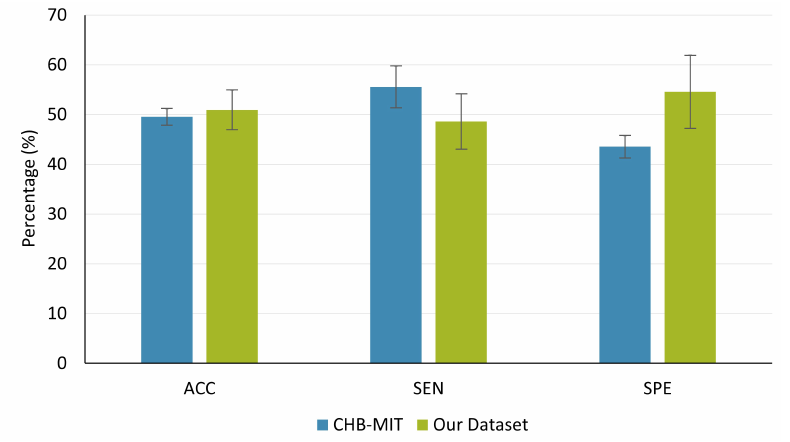
Figure 4. The results of the LOO validation method on the CHB-MIT data set and our data set to classify interictal and preictal phases are indicated. The bar chart displays the average performance metrics and the standard error of the